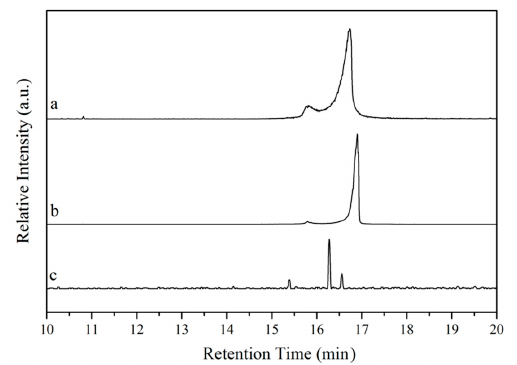
Figure 4. Chromatograms of ( a ) tung oil, ( b ) isolated α -eleostearic acid, and ( c ) tung oil methyl esters.